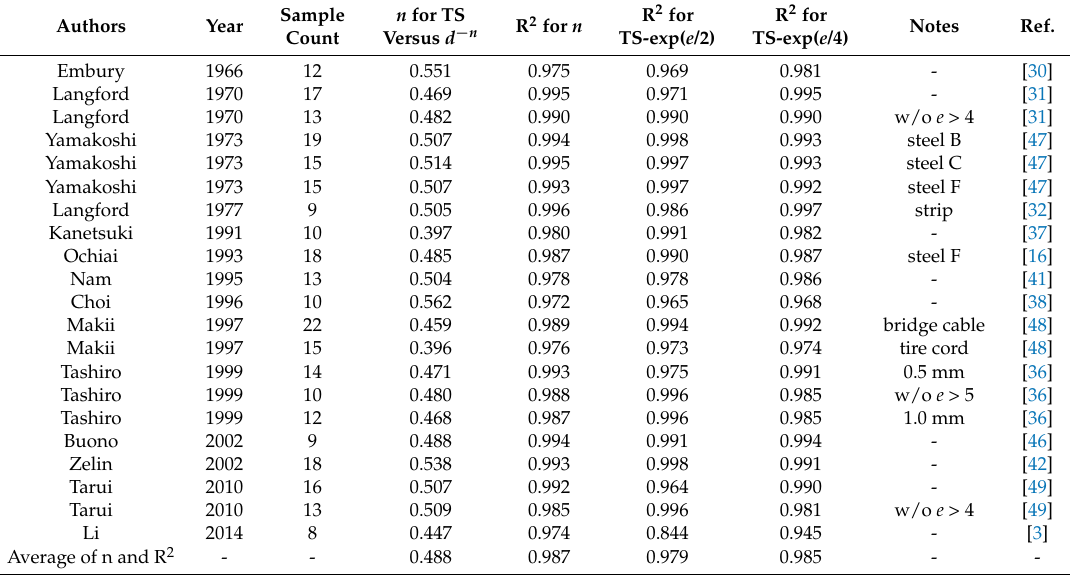
Table 1. Statistical data for comparison among the three types of